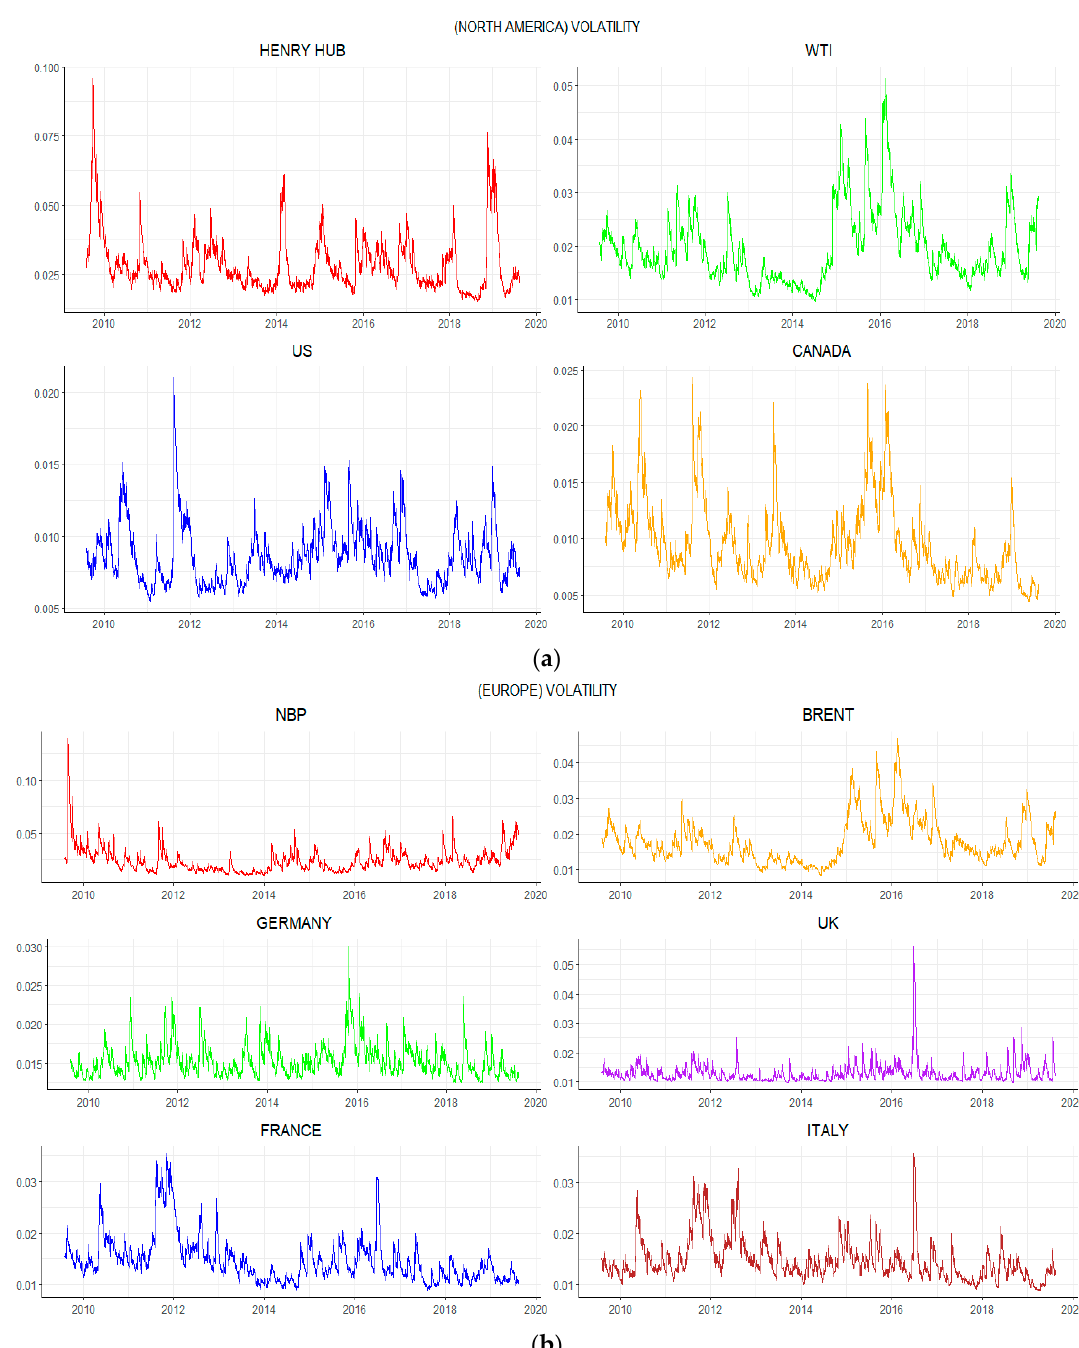
Figure 3. ( a ) Time-variations of the volatility series in North America. Notes: Henry Hub indicates natural gas; WTI indicates crude oil; US indicates the S&P 500 Utilities Index; CANADA indicates the S&P/TSX Capped Utilities Sector Index. ( b ) Time-variations of volatility series in Europe. Notes: NBP indicates natural gas; BRENT indicates crude oil; GERMANY indicates the DAX subsector for all electricity; UK indicates the FTSE 350 Electricity Index; FRANCE indicates the CAC Utilities Index; ITALY indicates FTSE Italia All-Share Utilities Index.